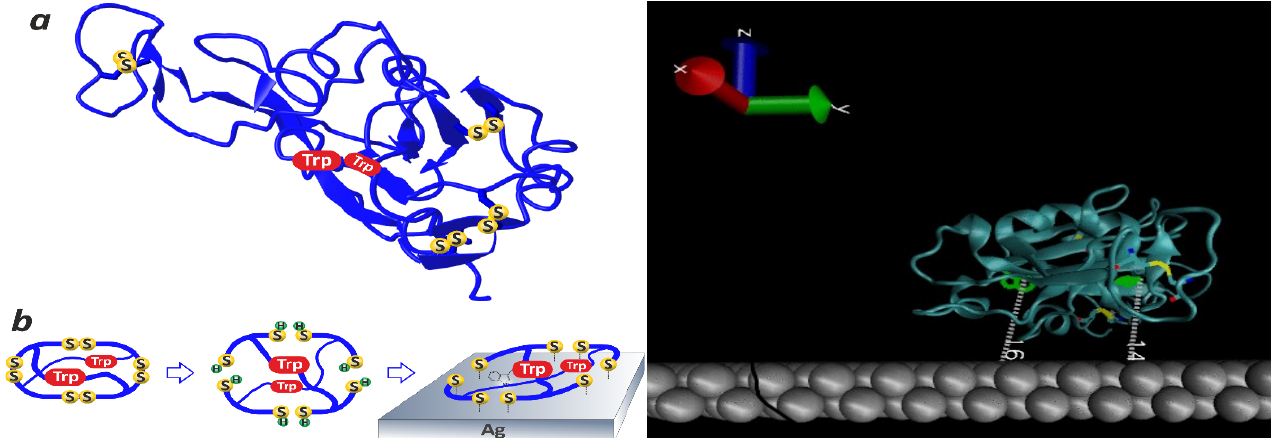
Figure 3. Left: A sketch illustrating the method for fabricating a metal–dielectric microcavity consisting of a dielectric protein globule of the RBD and the metal surface of the SERS-active substrate. The reduction of all four disulfide bonds of the RBD protein results in the formation of an additional eight free sulfhydryl groups capable of forming strong chemical bonds with silver atoms. The unfolding of the protein globule as a result of disulfide bond reduction leads to spatial approximation between the tryptophan (Trp) residues and the surface of the SERS-active substrate and the domi- nance of Trp in the SERS spectrum (see the data presented in Section 3.1 below). Right: A sketch of the structure of the native RBD of the SARS-CoV-2 S glycoprotein applied onto the silver surface of the SERS-active substrate. The distances between the surface of the SERS-active substrate and two Trp residues of the RBD amino acid sequence located deep in the protein globule are indicated. The data were calculated from the atomic coordinates of the three-dimensional structure of the RBD protein reported in [13].